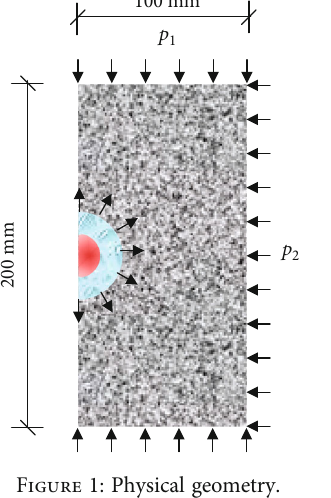
Figure 1: Physical